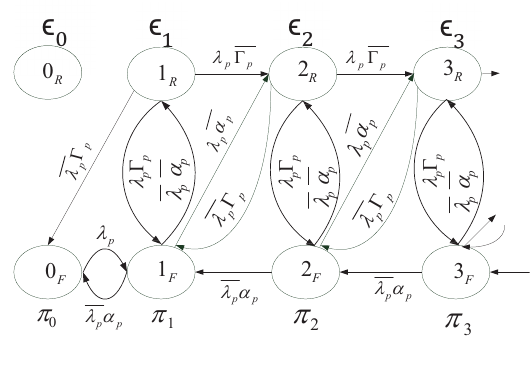
f . Probabilities Γ p = 1 − Γ p and 1